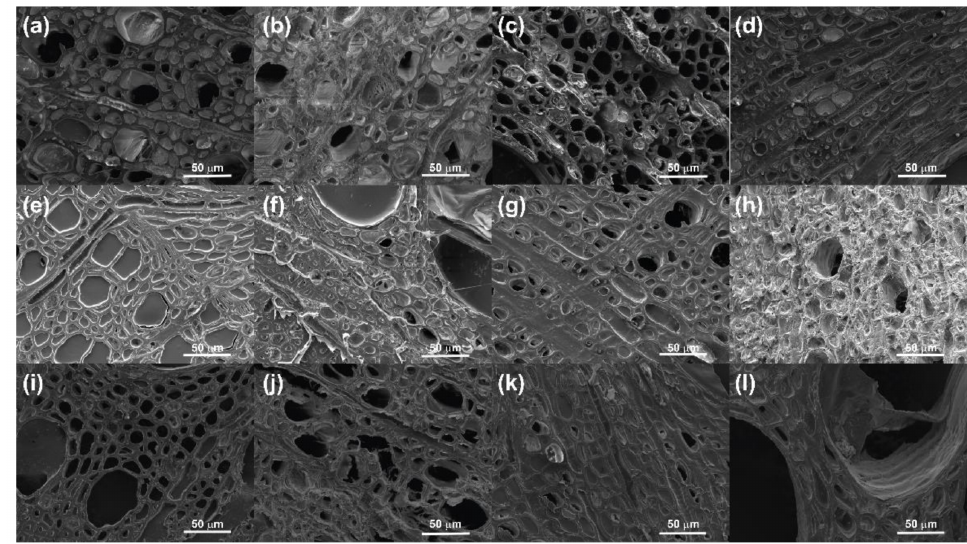
Figure 4. Scanning electron micrographs of chitosan-treated fresh wood after air- ( a ) and freeze- drying ( b ) and archaeological wood after air- ( c ) and freeze-drying ( d ); alginate-treated fresh wood after air- ( e ) and freeze-drying ( f ) and archaeological wood after air- ( g ) and freeze-drying ( h ); and CNC-treated fresh wood after air- ( i ) and freeze-drying ( j ) and archaeological wood after air- ( k ) and freeze-drying ( l ), magnification 1.11 k ×